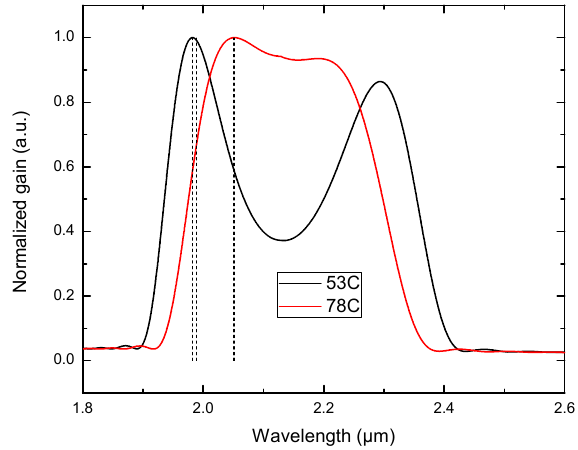
Figure 8. The calculated gain spectra in 10 mm PPKTP with 38.75 µ m period at temperatures of 53 ◦ C (solid black line) and 78 ◦ C (red line). The Dotted lines indicate the target spectral